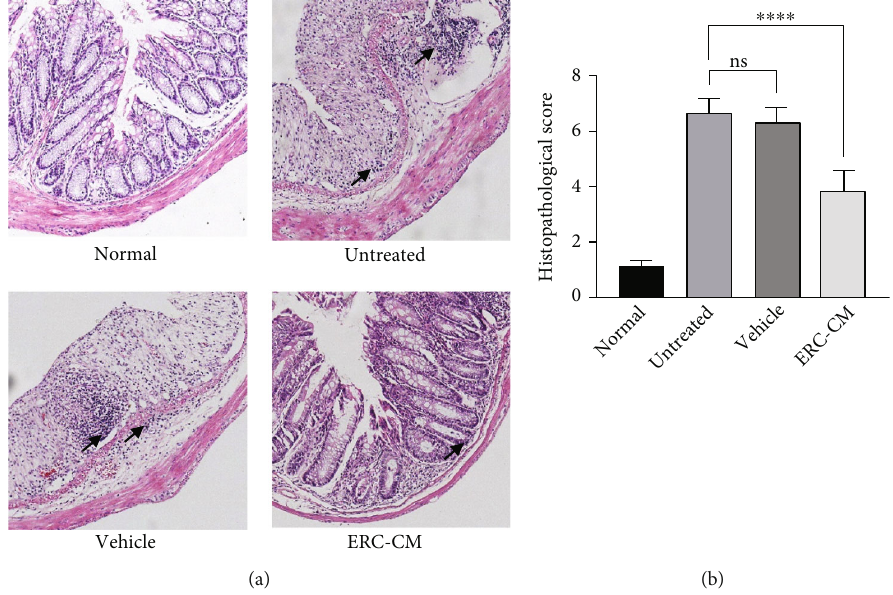
Figure 3: ERC-CM signi fi cantly alleviated colon damage in colitis. (a) Representative photomicrographs (100x, hematoxylin and eosin staining) of histological sections of the colon from each group. (b) Histopathology scores were evaluated and calculated as in previous studies [33]. The p value was determined by one-way ANOVA. ∗ p < 0 : 05 , ∗∗ p < 0 : 01 , ∗∗∗ p < 0 : 001 , and ∗∗∗∗ p < 0 : 0001